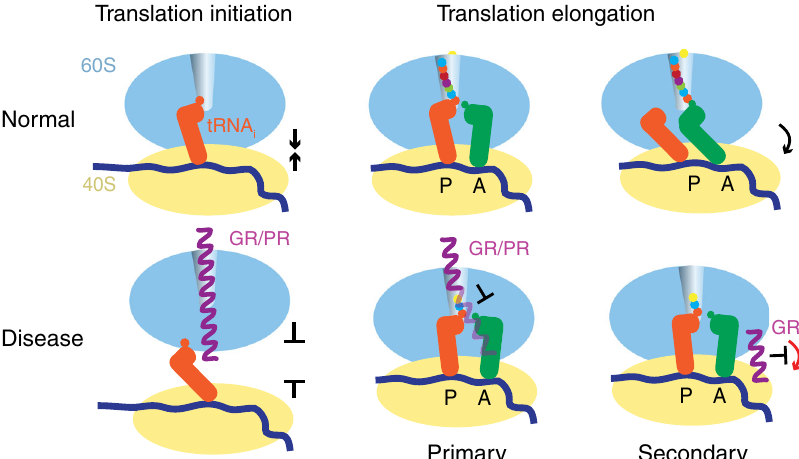
Fig. 6 Mechanism of translation repression by poly-PR and poly-GR (purple): binding to the 60S (blue) polypeptide tunnel is consistent with perturbation of translation initiation (this work and ref. 44 ) and binding to 80S inhibits translation elongation (this work and ref. 41 ). Poly-GR may also inhibit translation by binding to a secondary site at the interface of the 40S and 60S subunit thereby interfering with intersubunit